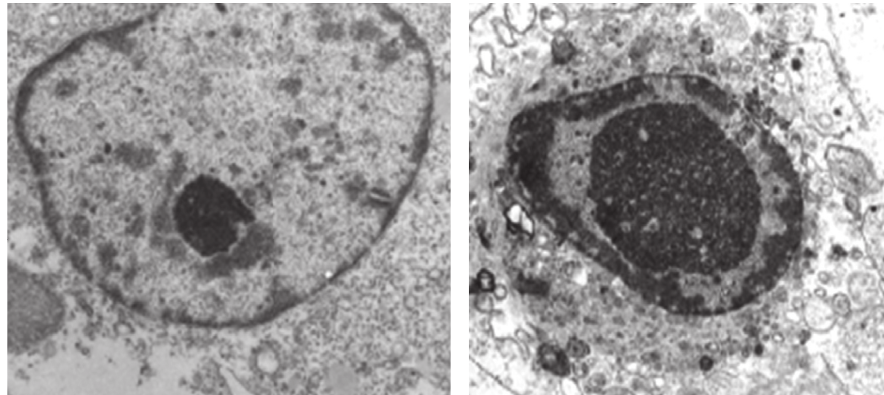
Figure 1: Cell ultrastructure ( × 2000) of the blank group (a) and shRNA-Livin-TMB+US group (b). Table 2: The mRNA expression levels of Livin, caspase-3, and caspase-8 in each group.